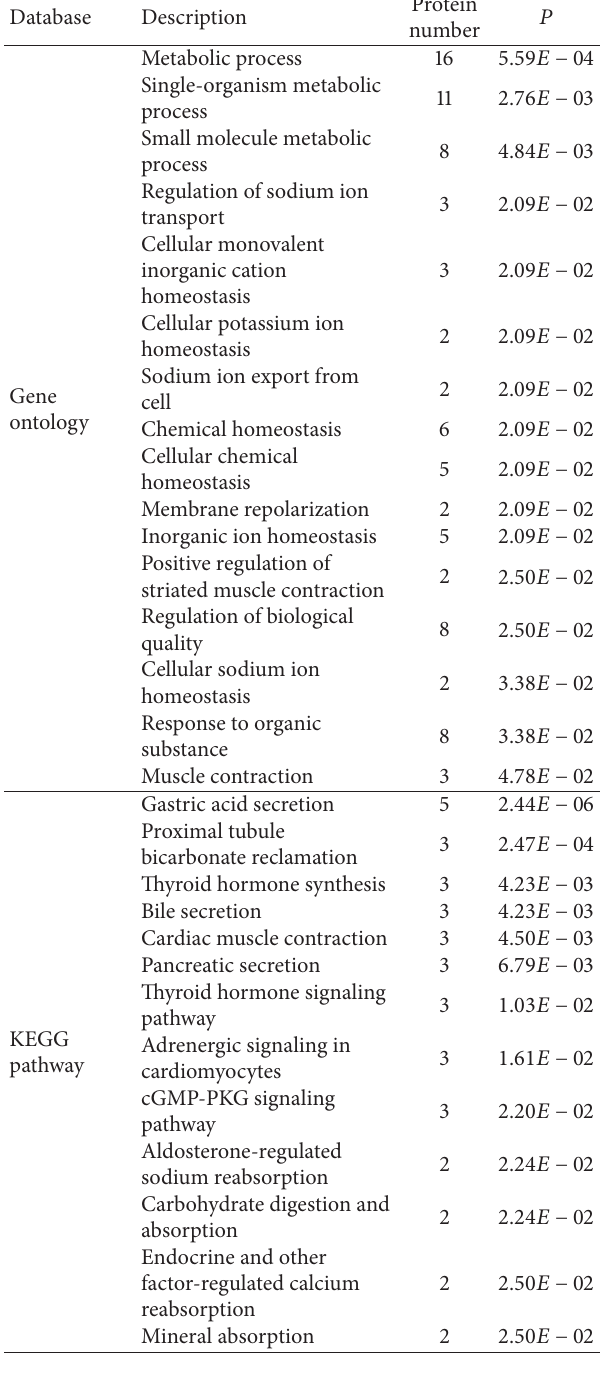
Table 2: GO and pathway enrichment analysis of the DPs normal- ized by MTF treatment database.